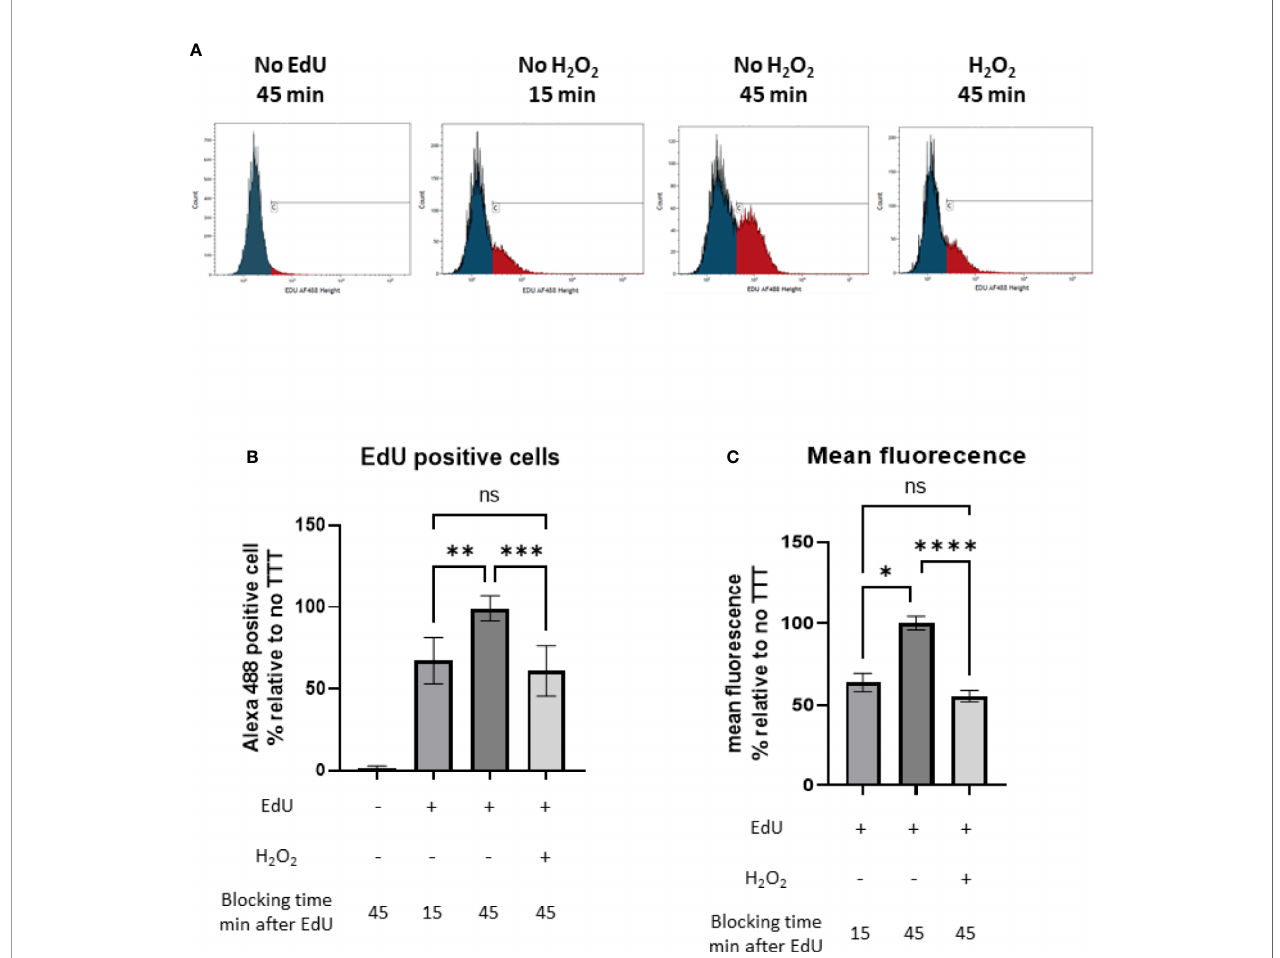
FIGURE 6 | Monitoring of the DNA synthesis by following the incorporation of the nucleotide analog EdU (5-ethynyl-2 ′ -deoxyuridine), Click-iT ® assay (Invitrogen) with and without H 2 O 2 treatment. (A) Number of events under fl uoresence intensity. Blue and red peaks represent respectively unspeci fi c binding of Alexa Fluor488 ® -azide (de fi ned by the control without EdU) and bacteria with active DNA replication. (B) Percentage of EdU positive S. aureus normalized to the untreated 45 min condition. (C) Arithmetic mean fl uorescence of EdU positive S. aureus normalized to the untreated 45 min condition. These results represent mean ± SD of three different experiments (three replicates for each condition). ns, not signi fi cant, *p < 0.05, ** p < 0.005, ***p < 0.001, ****p < 0.0001 by Kruskal-Wallis test with Dunn ’ s multiple comparison